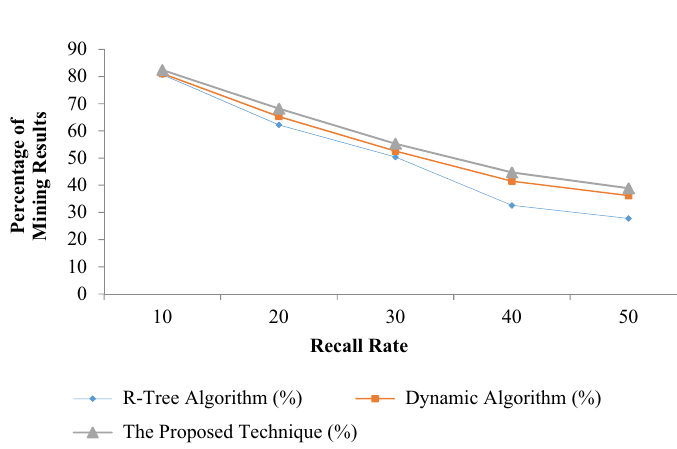
Figure 5: Comparison of the proposed technique in terms of accuracy at the level of recall